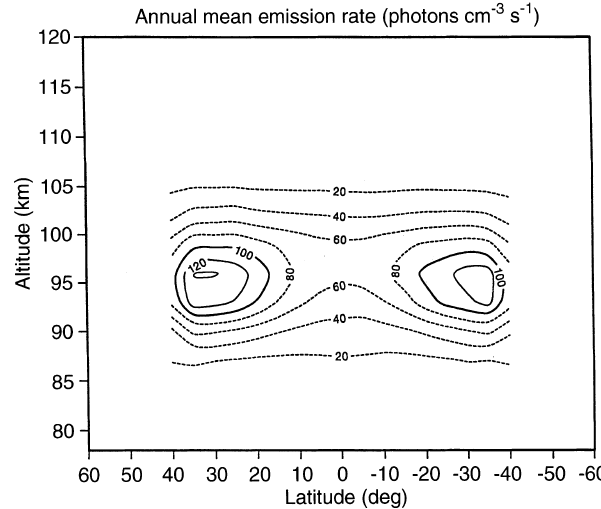
Fig. 8. Latitude-height distribution of the mean vertical wind in January